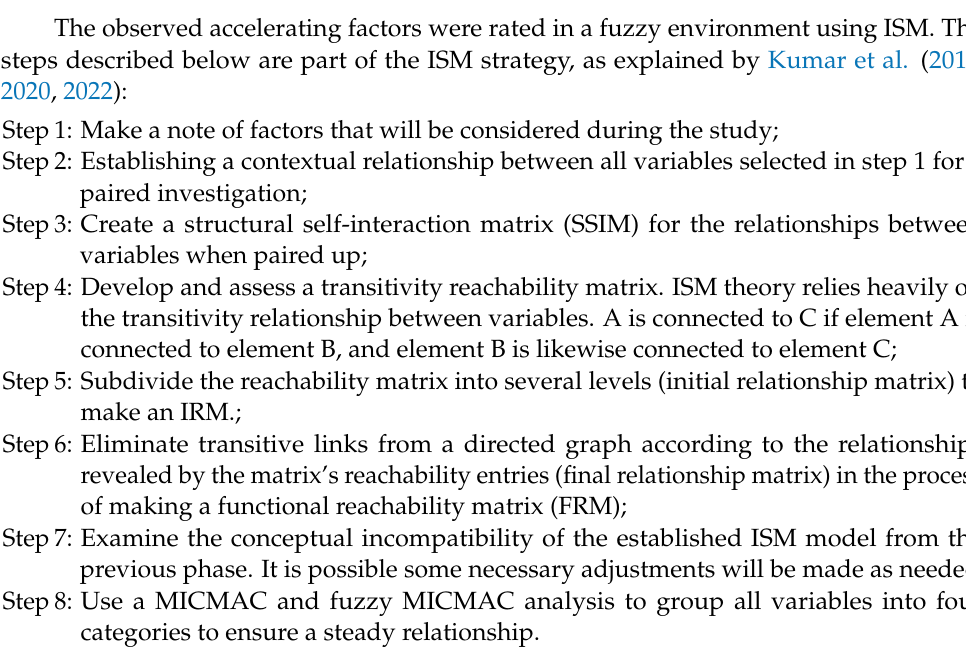
Figure 1. The framework of research.